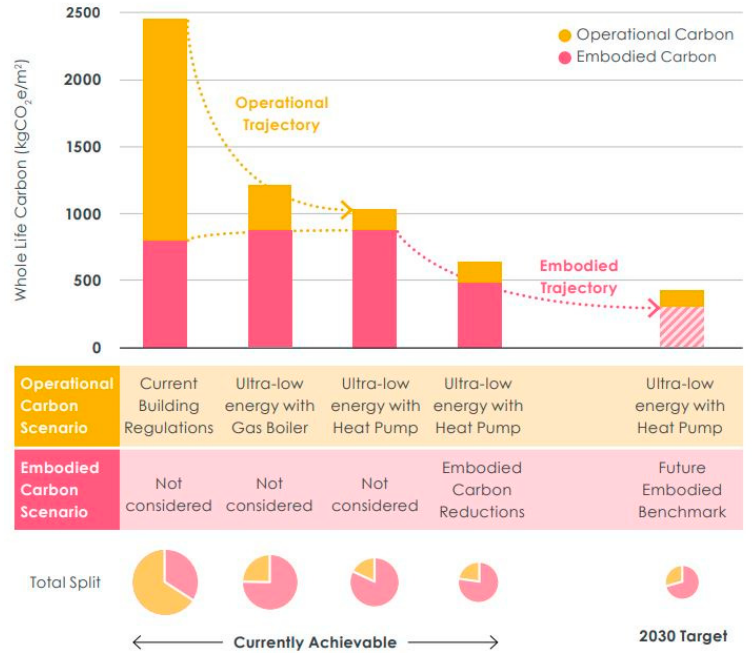
Figure 2. Embodied Carbon Trajectories Based on Different Scenarios and Current Regulations [11].